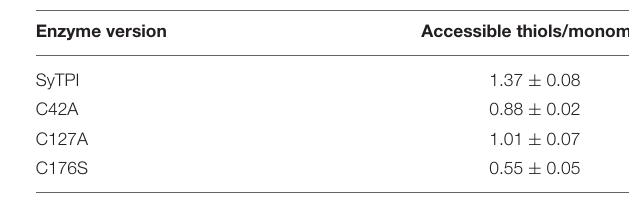
TABLE 3 | Accessible thiols in wild-type and mutants SyTPI determined by